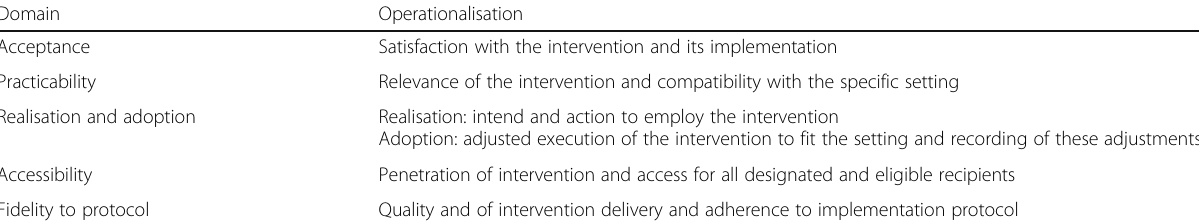
Table 1 Quantitative and qualitative feasibility assessment; type and description of analysis